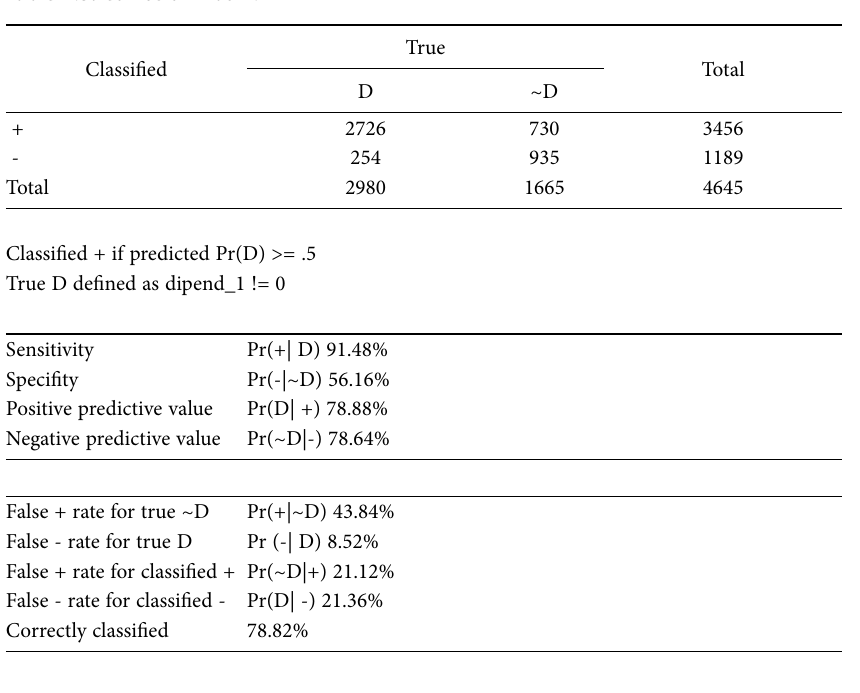
Table A. 3. Confusion Matrix.